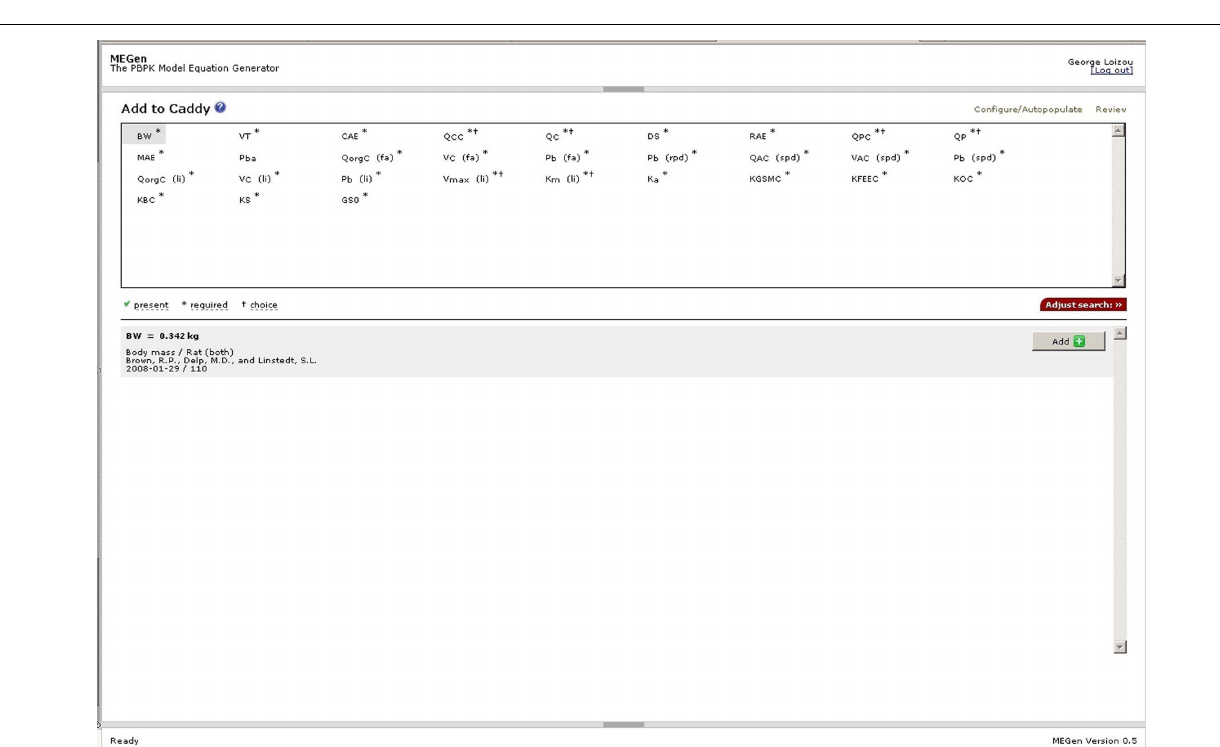
FIGURE 7 | Parameter selection using the